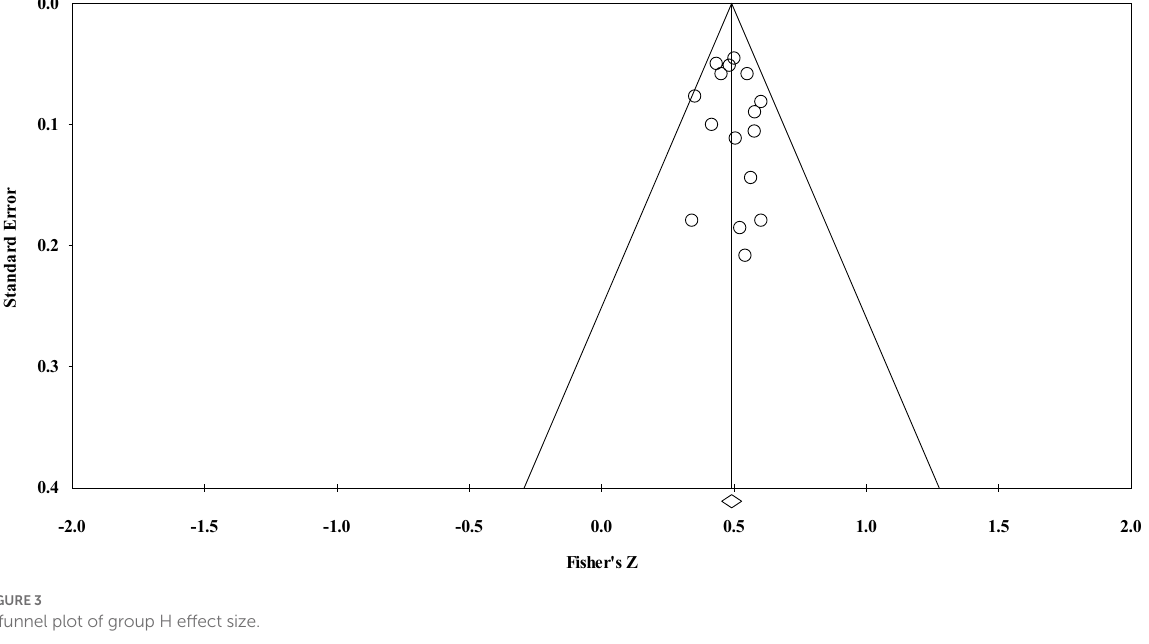
FIGURE 3 A funnel plot of group H effect